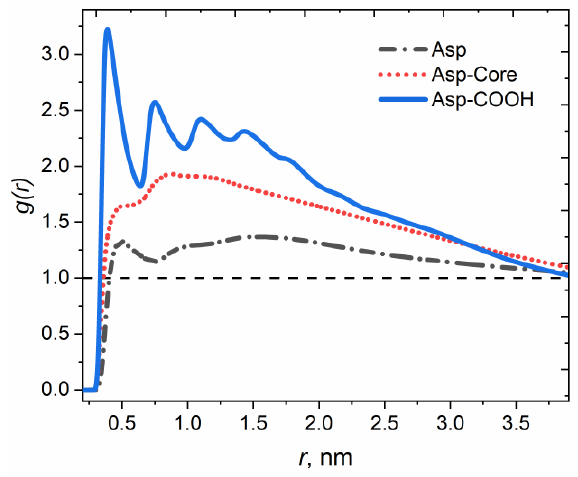
Figure 3. Intermolecular pair correlation functions g(r) between the asphaltenes calculated for the atoms in the polyaromatic cores of the asphaltene molecules (carbon and sulfur).